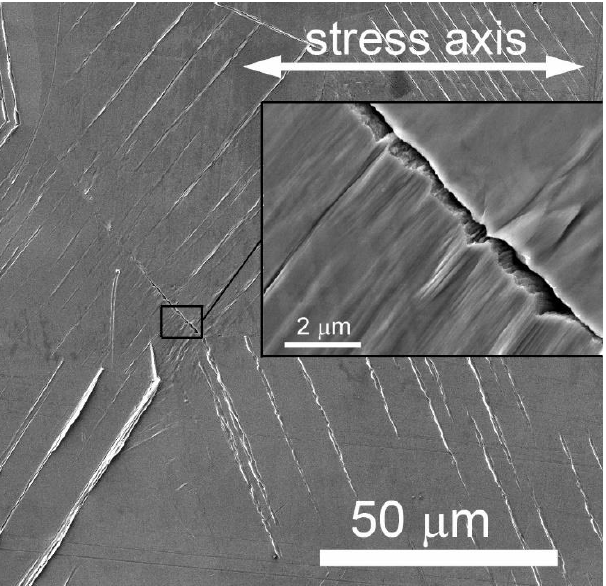
Figure 22. Surface of polycrystalline copper cycled with ε L = 4 × 10 −3 for 4000 cycles (4% N f ); a crack starting at an angled grain boundary; the inset shows the detail of a fine slip producing irregular nano-extrusions and nano-intrusions in between three regular PSMs (one producing a grain boundary extrusion and two producing grain boundary intrusions).